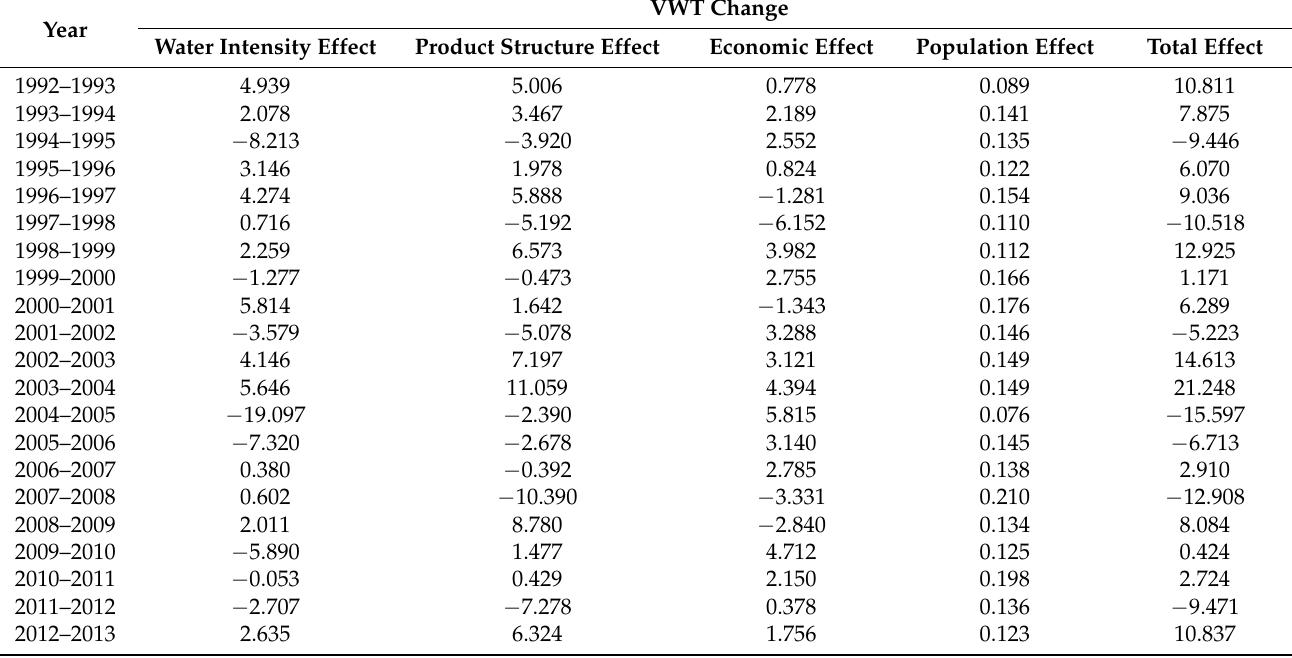
Table A4. The logarithmic mean divisia index (LMDI) analysis of millet virtual water trade (VWT) change in South Korea (million m 3